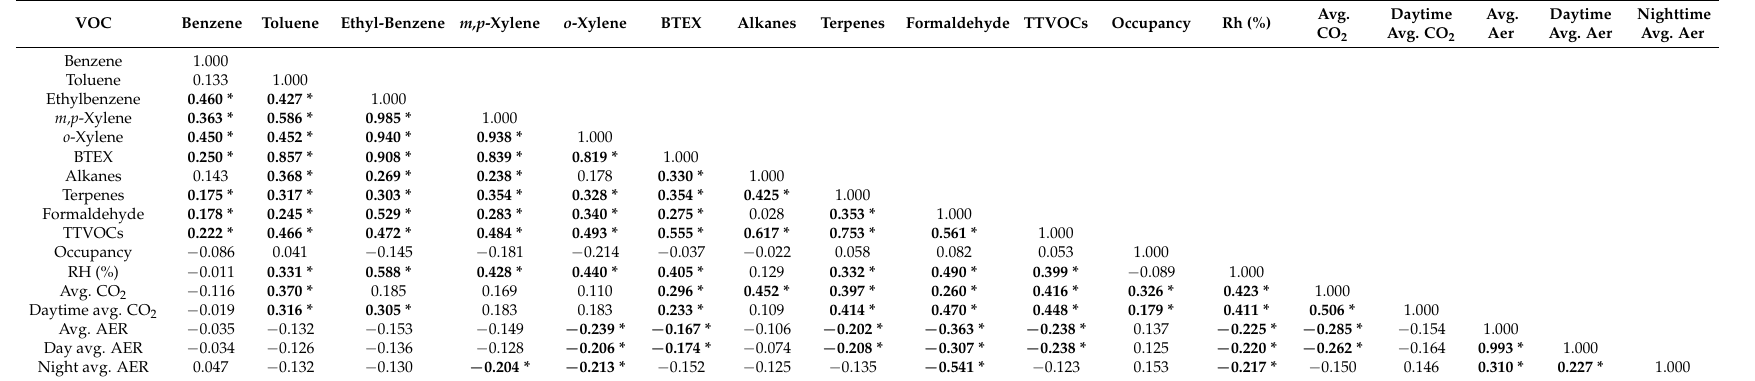
Table 2. Spearman rank correlation coefficients of indoor VOC concentrations and key IEQ parameters ( n =